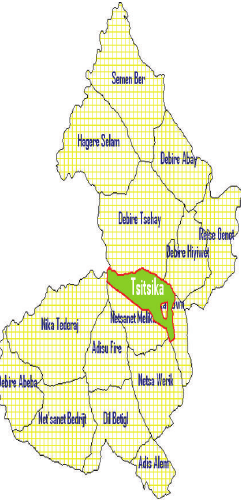
Figure 1: Map of Ziquala Woreda (study area), Northeast Ethiopia.